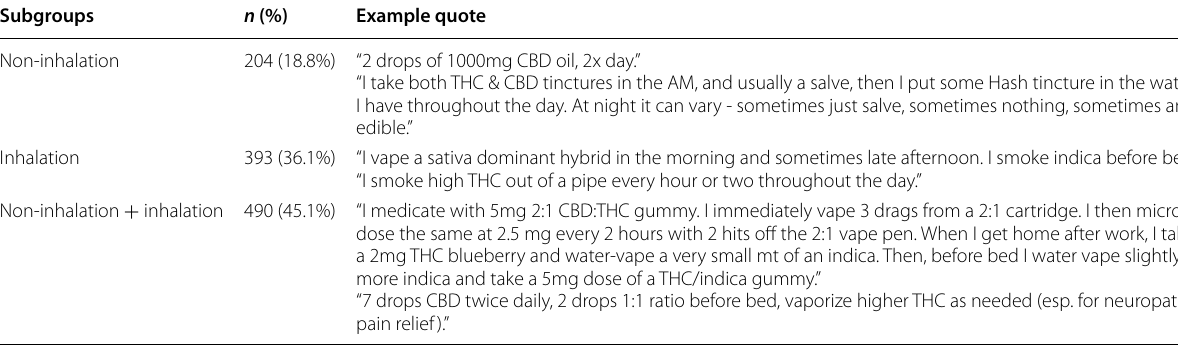
n 234 participants were excluded due to not responding, response vagueness, or because they did not mention administration routes. All groups are exclusive = THC tetrahydrocannabinol, CBD cannabidiol, AM morning